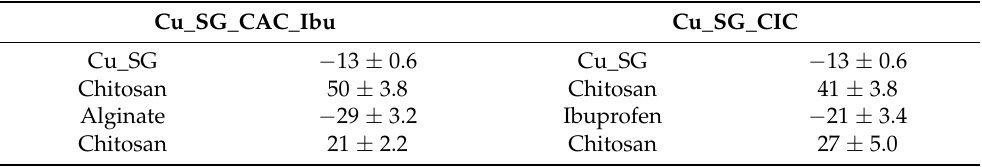
Figure 6. Potential measurement of ( A ) Cu_SG_CAC_Ibu, and ( B ) Cu_SG_CIC after each layer deposition. Table 3. Potential (mV) values of Cu_SG_CAC_Ibu, and Cu_SG_CIC after each layer